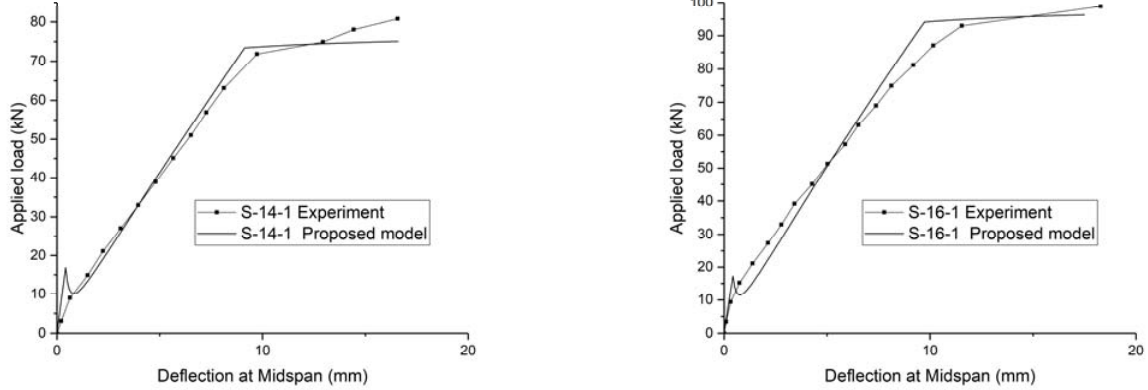
Buildings 2022 , 12 , 1964